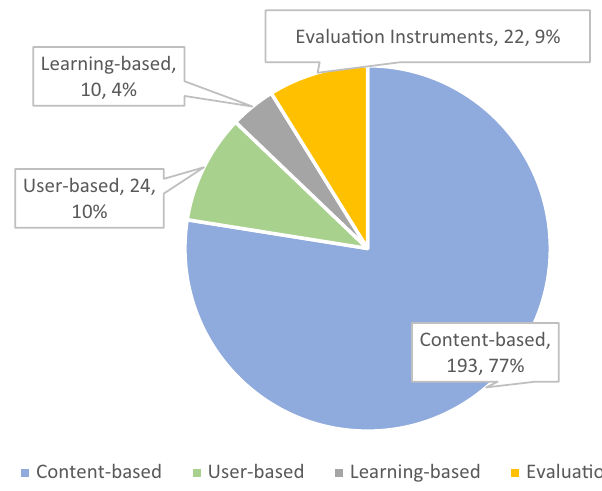
Fig. 10 Frequencies of categories for research on textbook